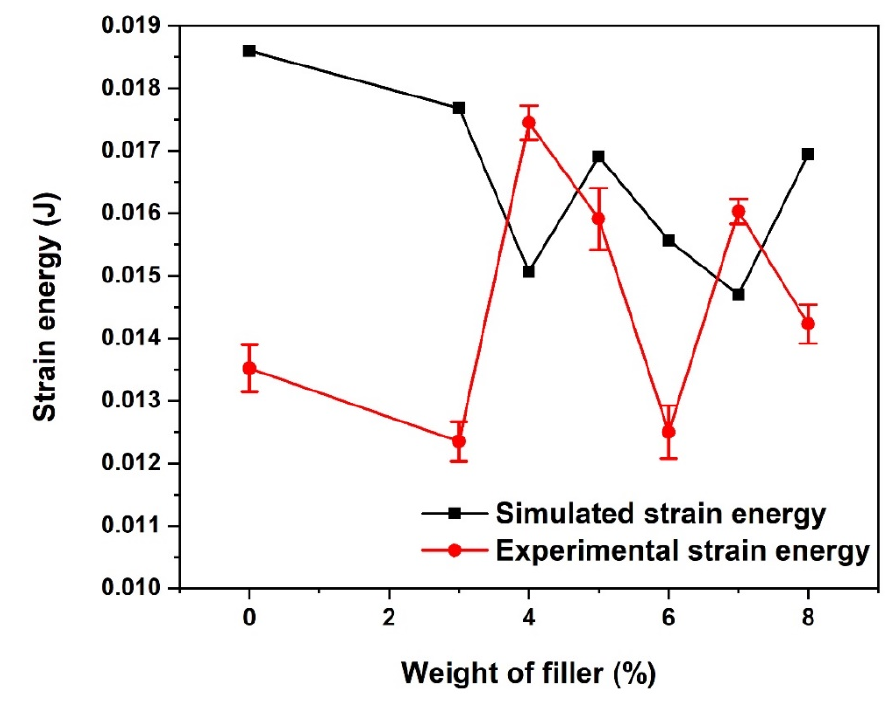
Figure 6. Energy-at-break of CCP-PLA nanofibre.